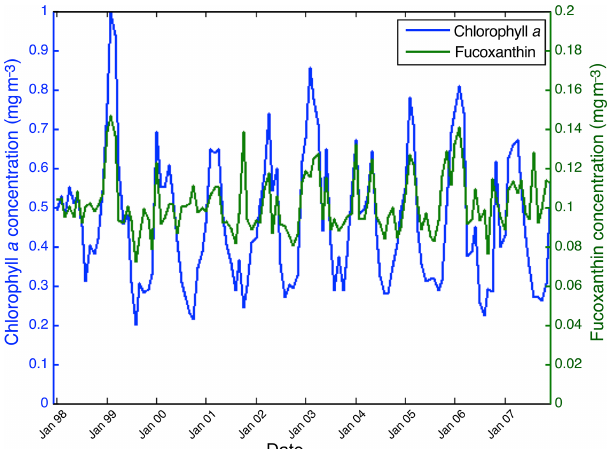
Figure 15. Chl a (in blue) and fucoxanthin (in green) concentrations for nearshore pixels (in the NSB